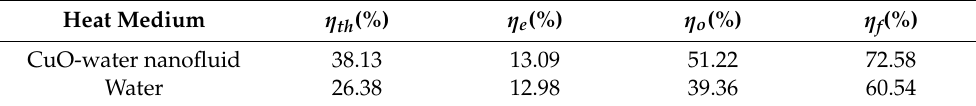
Table 6. The average efficiency of the PVT system using water and CuO-water